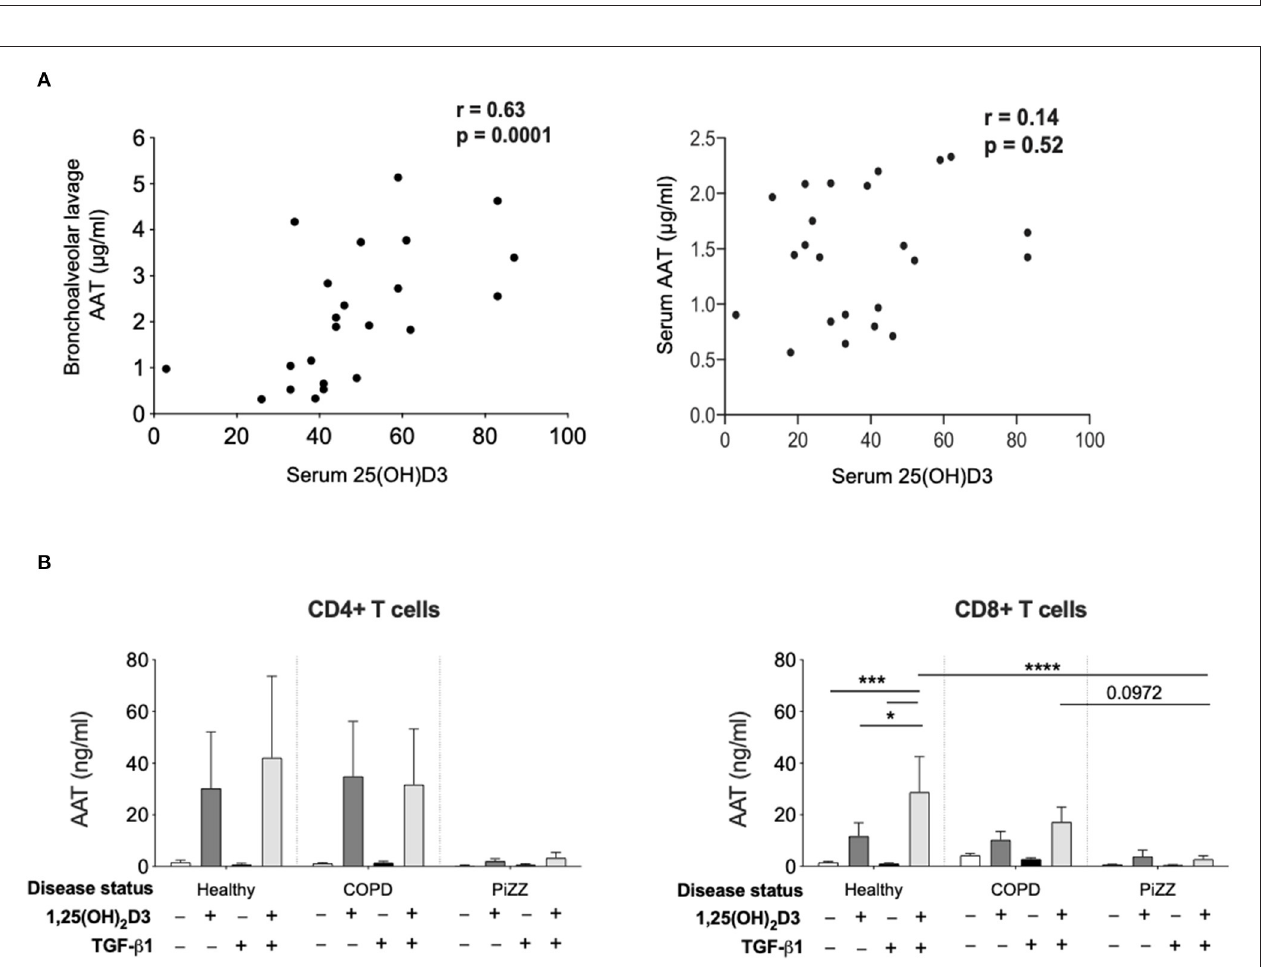
FIGURE 4 | ( n = 4) and cultured for 7 days in the absence or presence of either 100nM 1,25(OH) 2 D3 or 100nM 25(OH)D, with or without 2ng/ml TGF- β 1. Cell pellets were harvested and assessed for SERPINA1 expression. (B) Human bronchial epithelial cells (HBEC, n = 5) were analysed for TGFB2 gene expression following 24h stimulation with NIST and different concentrations of 25(OH)D3 (10, 100, and 1,000nM). (C) HBEC ( n = 7) were assessed for their ability to produce bioactive TGF- β in response to 48h 1 µ M 25(OH)D3. Cells were cultured for 7 days in the presence or absence of 100nM 1,25(OH) 2 D3 with or without TGF- β 1 or TGF- β 2 (0.2,